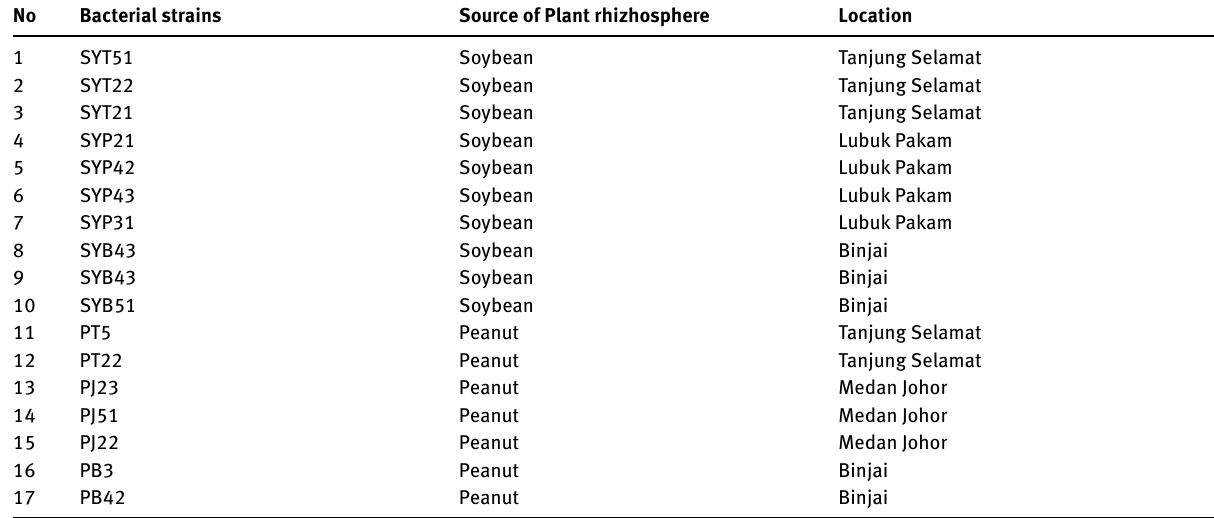
Table 1: Bacteria that were isolated from the rhizosphere of soybean and peanut No Bacterial strains